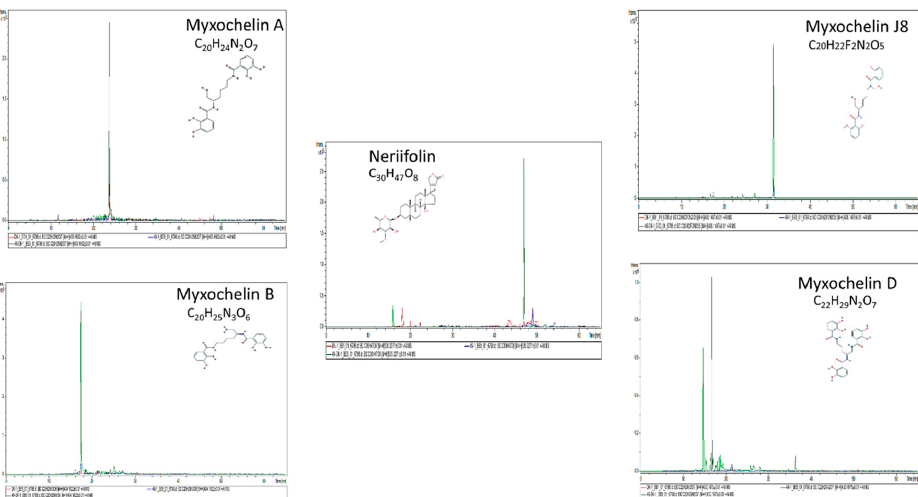
Figure 6. Production of different reported secondary metabolites during boundary